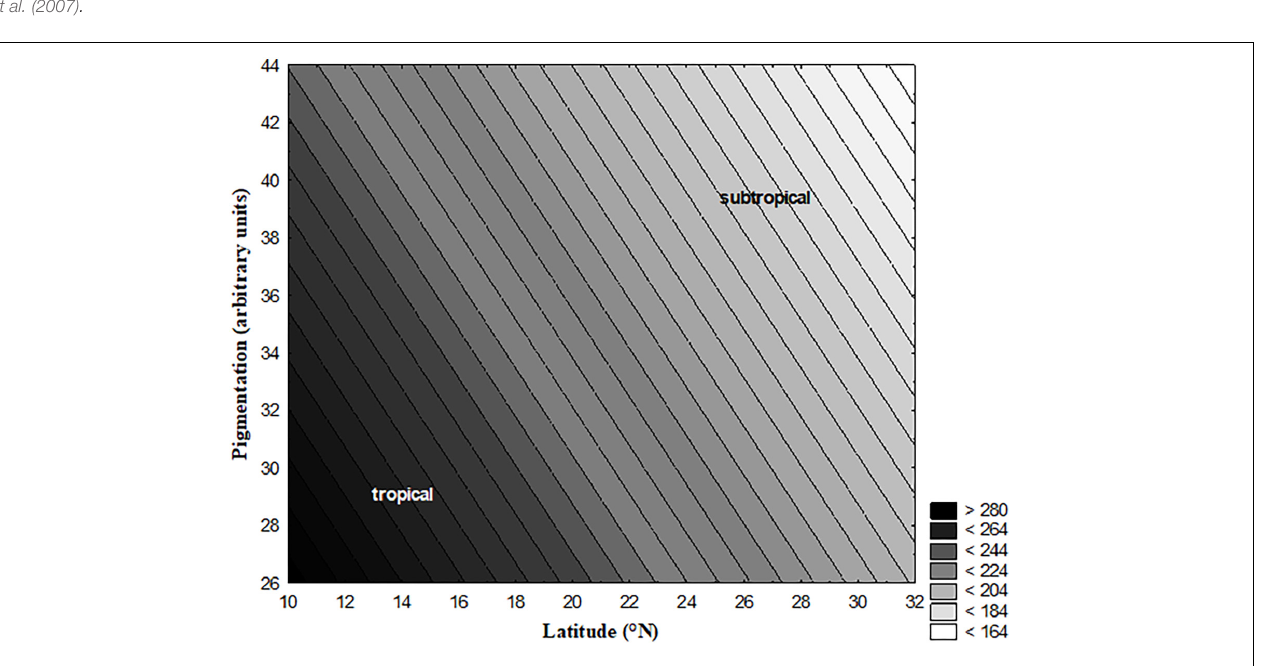
FIGURE 1 | 3D Contour plot showing erythemal ultraviolet data against latitude and pigmentation. The data presented in this figure has been developed at NASA Goddard Space Flight Center (GSFC). The erythemal ultraviolet values presented here in this figure are averages of monthly values recorded from 1996 to 2003. The values shown on Z -axis (UV Range) were calculated from mantissa (M) and exponent (E). For further details see ftp://toms.gsfc.nasa.gov/pub/eptoms/ data/erythemal/Y2005/L3_eryln_ept_20051214.txt.